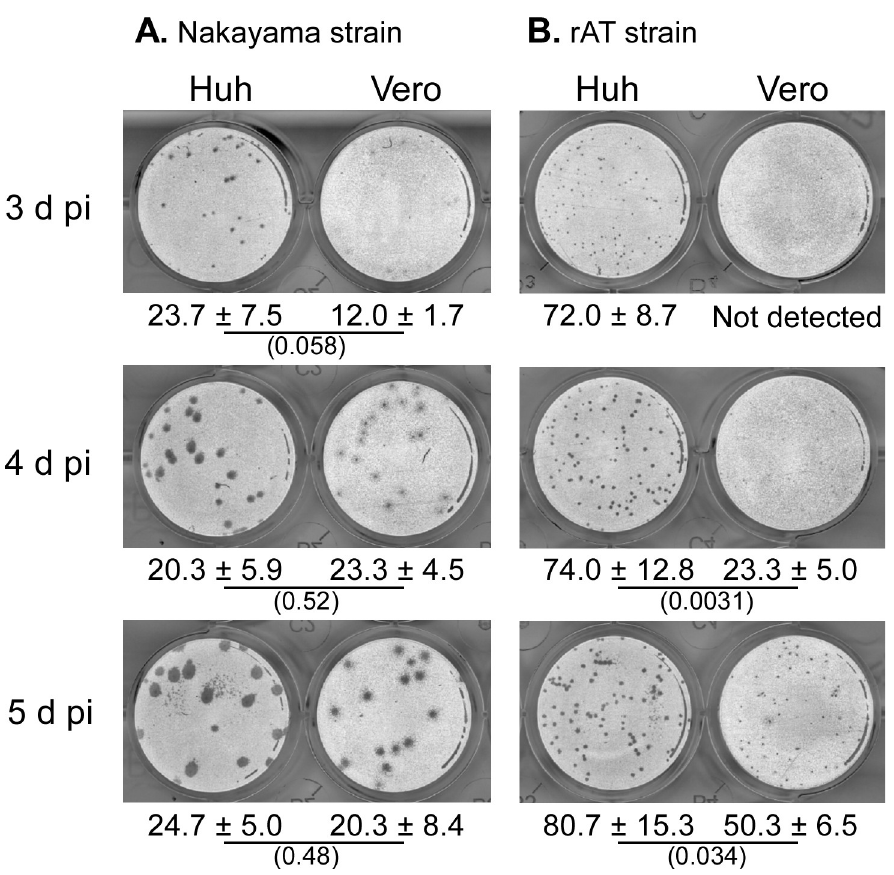
Fig 7. Huh7.5.1–8 cells supported a more rapid development of JEV plaques than Vero cells. Representative black- and-white inverted images of plaques of the JEV Nakayama strain (A) and the rAT strain (B) in Huh7.5.1–8 (Huh) and Vero cells. Cells were fixed and stained at the indicated times. Values given below the images indicate plaque numbers expressed as the mean ± SD of triplicates from one representative experiment. Statistical significance was determined by an unpaired two-tailed t test. Values in parentheses indicate p values, and those less than 0.05 were considered statistically significant. Similar results were obtained in two other independent experiments (S7 Fig).